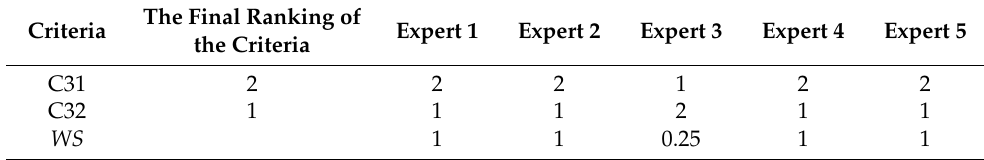
Table 10. The WS coefficients of the sub-criteria of C3.